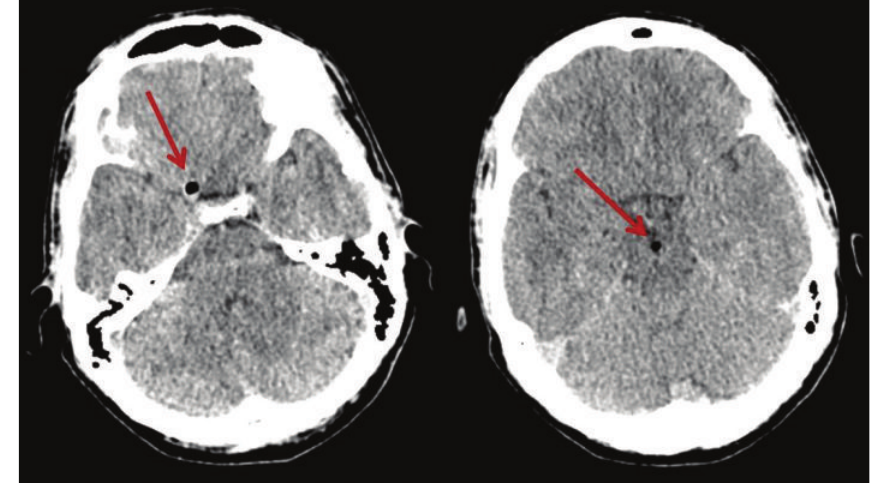
Figure 3: Cranial CT scan showing